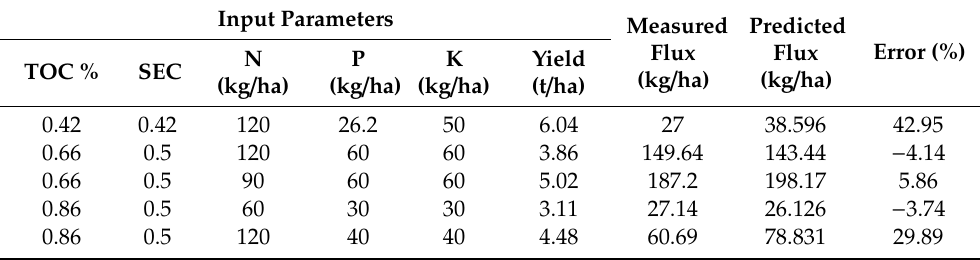
Table 5. Fluxes predicted for five independent datasets that were not used for training the model. Input Parameters Measured